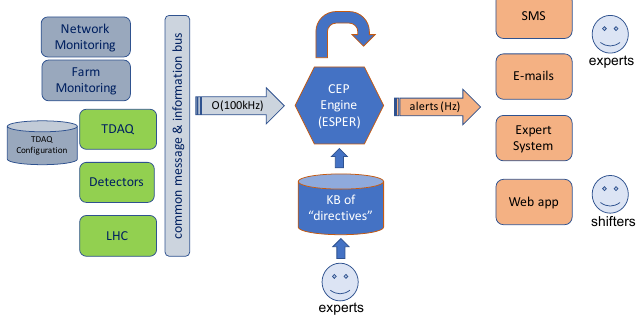
Figure 1. View of a shifter working environment in ATLAS Control Room Figure 2. Architecture of Shifter